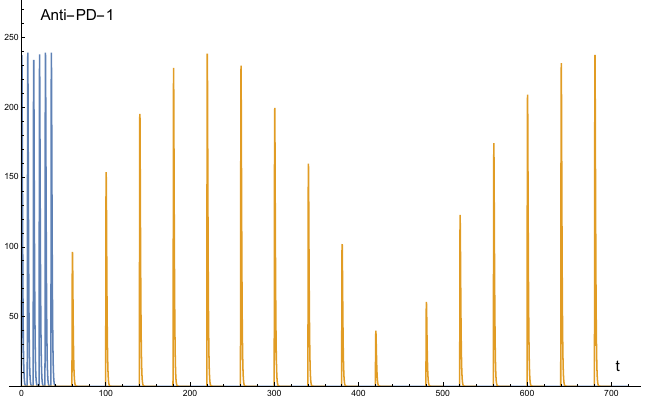
Figure 4. The y-axis represents the dosage of the ANTI PD-1 treatment and x-axis represents the time in days. The doses and the time of administration of the drug varied.